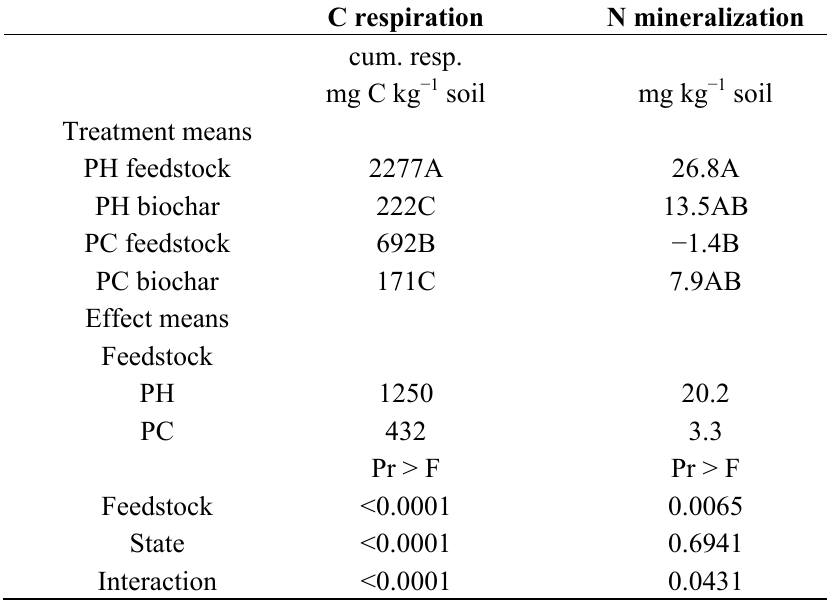
Table 4. Treatment and selected effect means and probabilities of cumulative C − -N from 24-day respiration respiration, mineralized NH 4+ -N, and NO 3